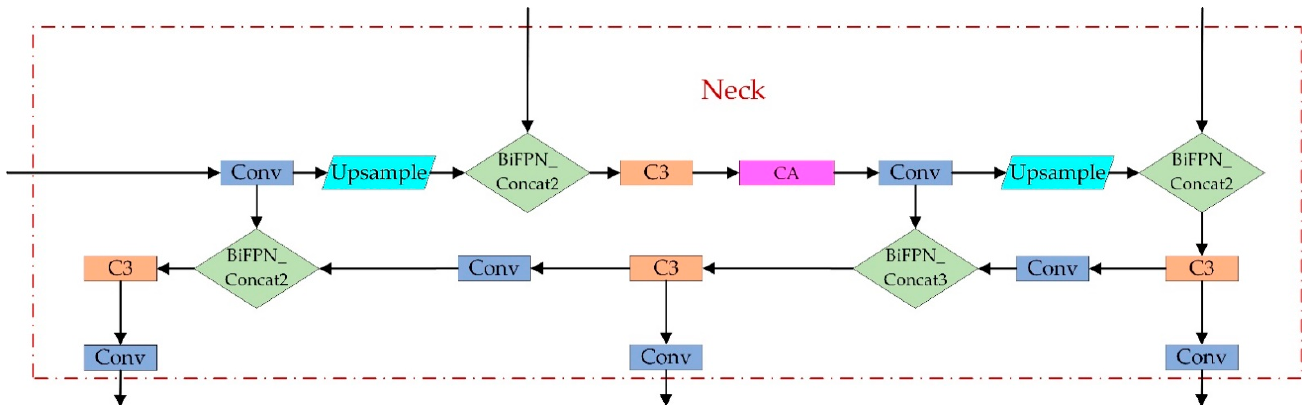
Table 2. Distribution of different types of samples in the data